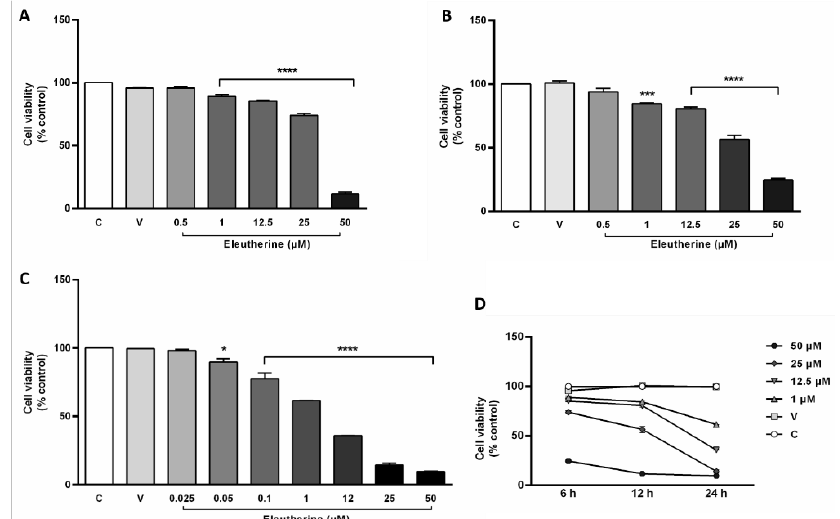
Figure 3. Eleutherine reduced the viability of glioblastoma cells as measured by the MTT assay. Cells were treated with different concentrations of eleutherine for 6 h ( A ), 12 h ( B ), and 24 h ( C ). ( D ) Cell viability curve showing the concentration and time-dependence of eleutherine’s effect. Data are presented as the mean ± SEM of three independent trials. Here, * p < 0.05, *** p < 0.001, and **** p < 0.0001 vs. untreated control (ANOVA, Tukey’s post hoc test); C, control; V, vehicle.